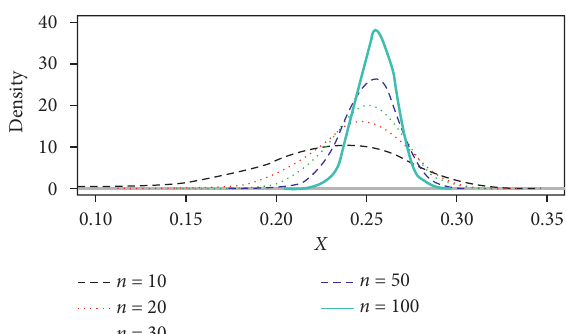
Figure 1: The estimated PDF’s of R 0 . 1